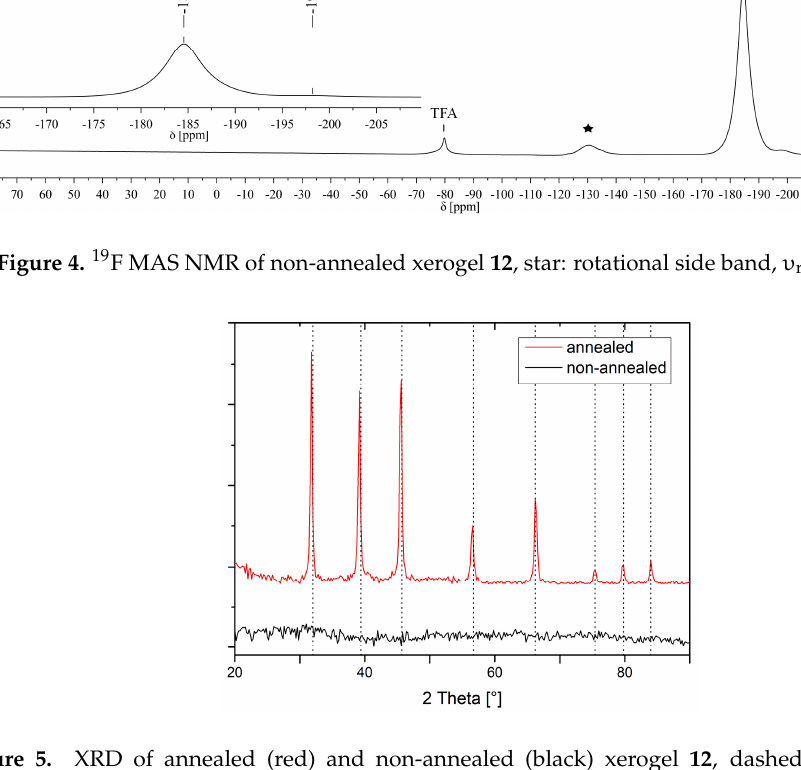
Figure 5. XRD of annealed (red) and non-annealed (black) xerogel 12 , dashed lines: KMgF 3 (pdf: 18- 1033, star).